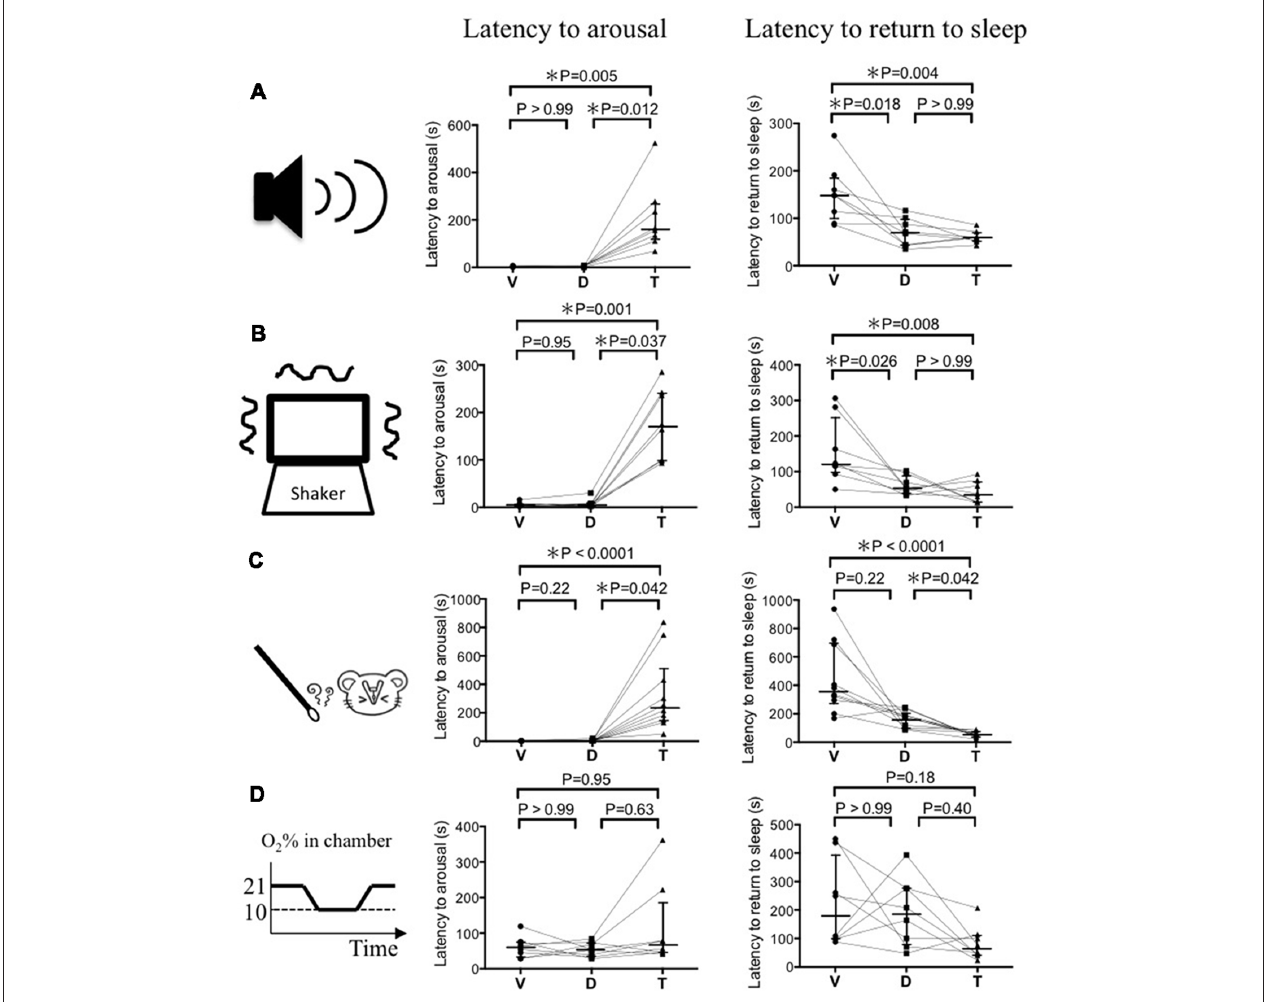
FIGURE 2 | Latency to arousal and latency to return to sleep induced by four modalities of sensory stimulation. (A) Auditory stimulus by ultrasonic sound ( n = 8). (B) Vestibular stimulus by cage shaking ( n = 8). (C) Olfactory stimulus by a predator odor ( n = 10). (D) Autonomic stimulus by hypoxia ( n = 8). Each animal received vehicle (V), DORA-22 (D), and triazolam (T) in a randomized order on spaced days and were tested for one of the stimuli 2–3 times. The value from those tests were averaged and are represented as a single dot. Data from the same animal are connected with lines to show possible drug interactions within an individual animal. Horizontal lines indicate, from top to bottom, 75 percentile, median, and 25 percentile, respectively. Statistical results using the Friedman test, a repeated measure nonparametric multiple comparisons test, are indicated in the graph. Note that latency to arousal in DORA-22 treated mice is not different from those in vehicle treated mice and significantly shorter than those in triazolam treated mice, with the exception of hypoxia. Also note that latency to return to sleep in DORA-22 treated mice is significantly shorter than those in vehicle treated mice and not different from those in triazolam treated mice at least for auditory and vestibular